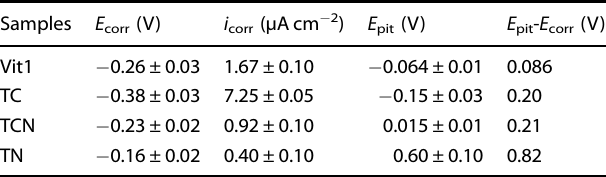
Table 1. Electrochemical parameters of the polarization curves of the four samples in 3.5 wt. % NaCl at 298